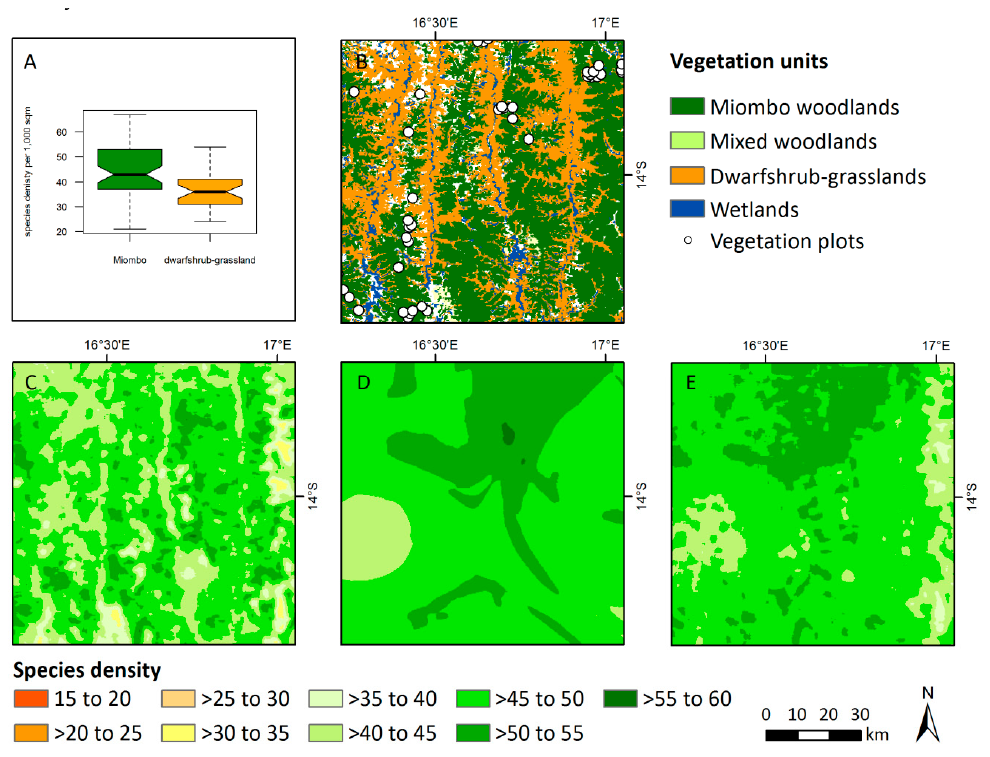
Figure 5. Plant alpha diversity (species density per 10 3 m 2 ) in the Miombo region. ( A ) Observed species density of the vegetation units “Miombo woodlands” and “dwarf shrub/grassland” in the upper reaches of the Okavango Basin derived from vegetation-plot database. “Miombo woodlands” (mean = 44.0, SD = 10.8) exhibit significantly higher species density than “dwarf shrub-grasslands” (mean = 35.9, SD = 7.3) according to a two-group t -test ( p < 0.001); ( B ) Major vegetation units of the area according to Stellmes et al. [39] and location of vegetation plots; ( C ) Species density as predicted by BRT on the “ RS TOPO ” dataset; ( D ) Species density predicted by BRT on the “ CLIMATE ” dataset; ( E ) Species density predicted by BRT on the “ ALL ” dataset.